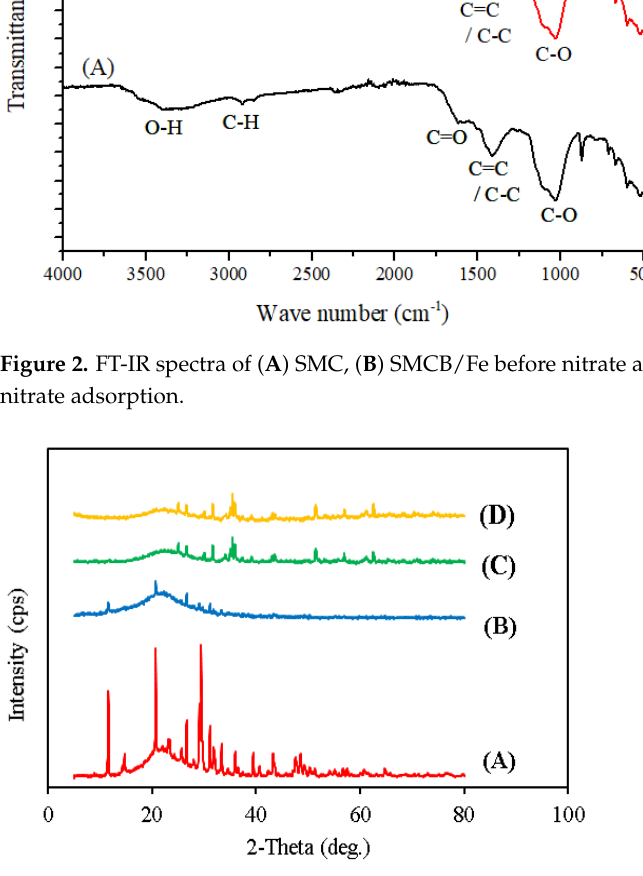
Figure 3. XRD pattern for SMC ( A ), SMC/Fe ( B ), SMC/Fe before adsorption ( C ), and SMCB/Fe after adsorption ( D ).